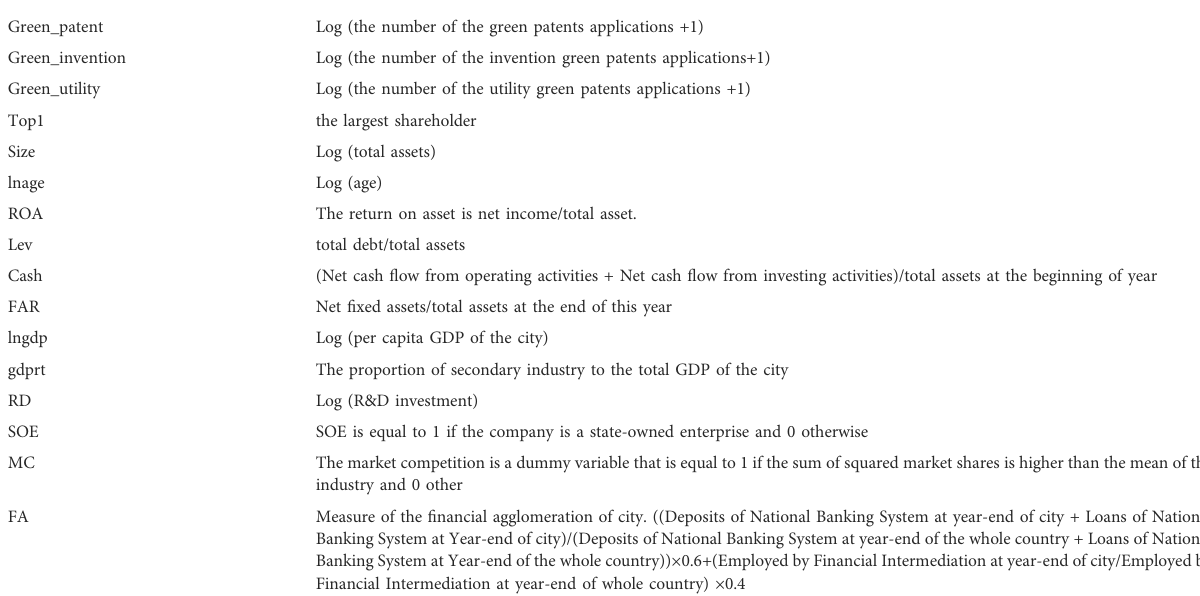
TABLE 2 Evaluation index of study variables. Variable